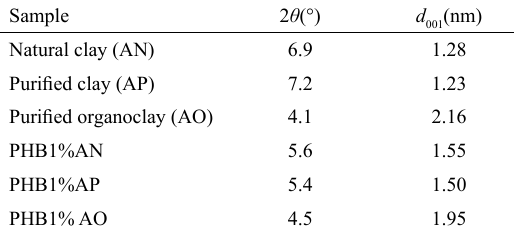
of the Bentonites and PHB 001